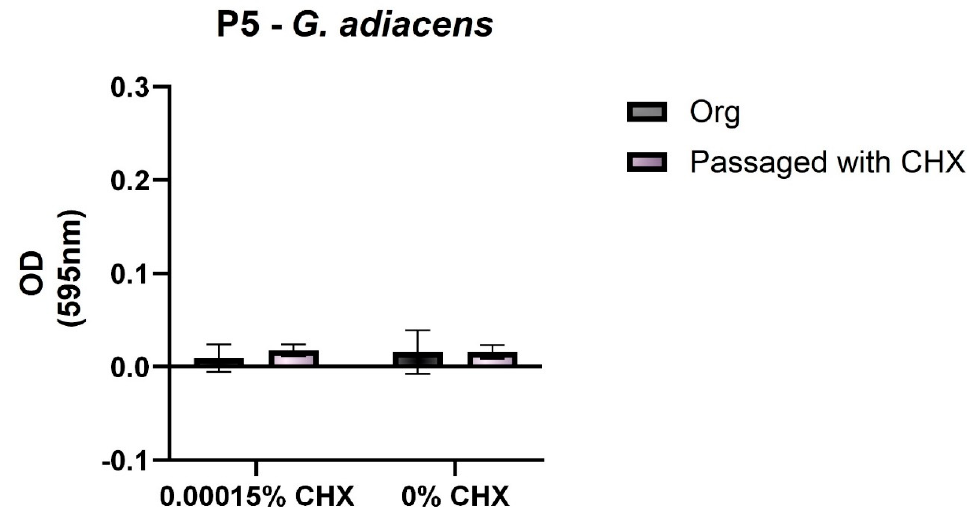
Figure 4. Biofilm formation at different subinhibitory concentrations of chlorhexidine (CHX). Graphical illustration of the biofilm formation (OD values) of G. adiacens exposed to subinhibitory concentrations of CHX. Percentages of CHX are shown on the X -axis, and the OD values are shown on the Y -axis. P5: Proband 5.